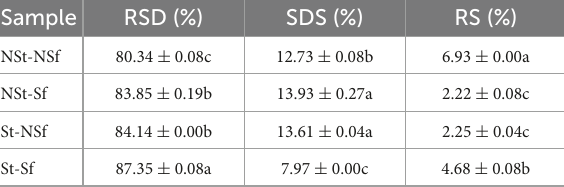
TABLE 3 Effects of steaming and sulfur fumigation treatment on different starch contents in Gastrodia elata. Sample